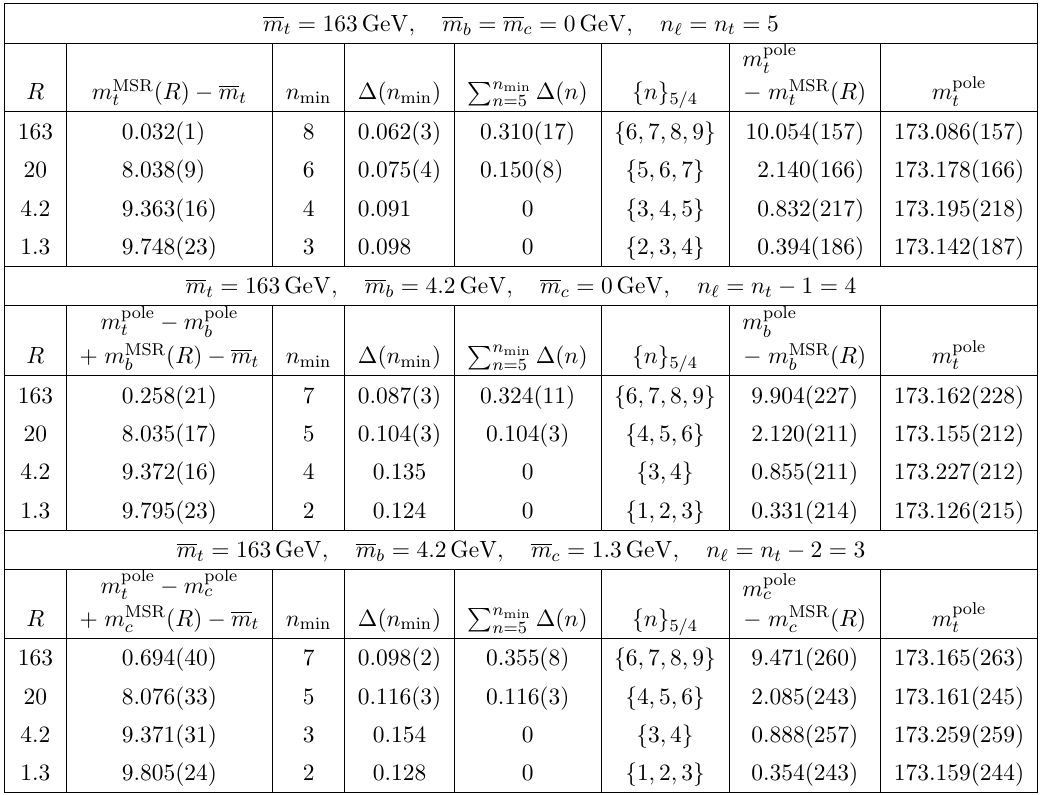
Table 5 . Details of the numerical results of our method to determine m pole for the cases of t massless bottom and charm quarks (upper section), massless charm quarks (middle section) and (cid:12)nite bottom and charm quarks (lower section) and exploring di(cid:11)erent setups to determine m pole . t The (cid:12)nal respective results for m pole are shown in the last column. See the text for details. All t numbers for masses and mass di(cid:11)erences are in units of GeV. Errors are quoted in parentheses.